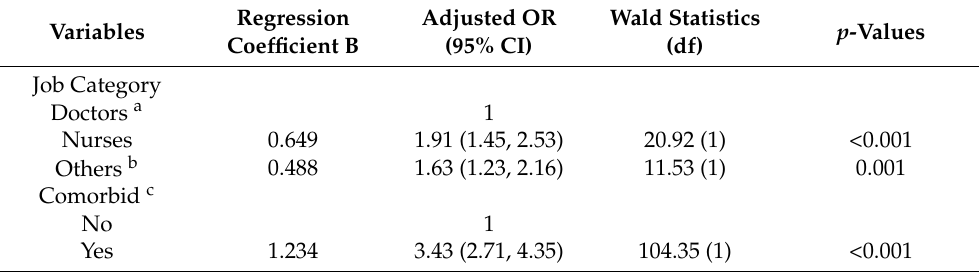
Table 5. Multiple logistic regression modelling of factors associated with obesity among